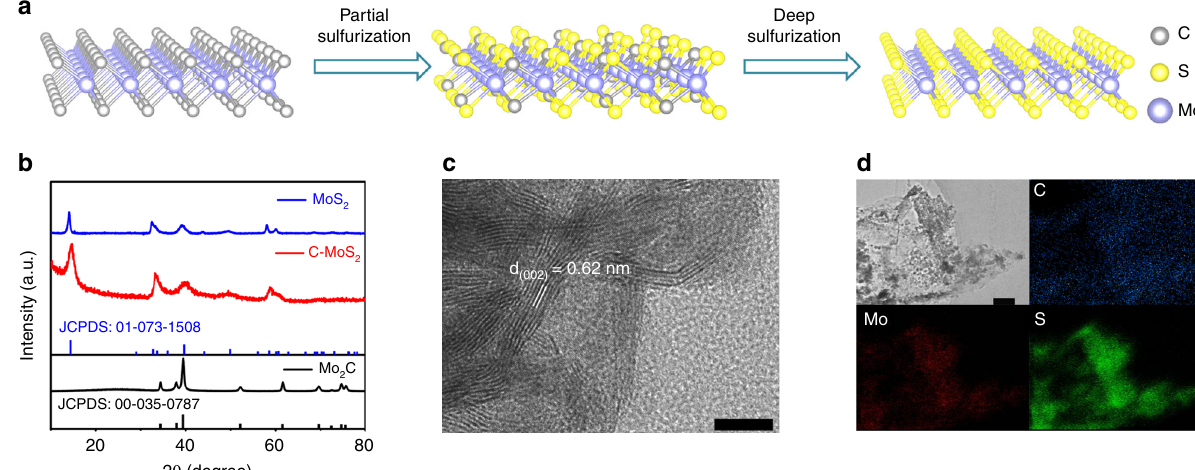
Fig. 2 Synthesis and characterization of C – MoS 2 nanosheets. a The schematic illustration of the synthesis of C – MoS 2 and MoS 2 . b The XRD patterns of Mo 2 C, C – MoS 2 , and MoS 2 . c The HRTEM image of C – MoS 2 . The scale bar is 10 nm. d The TEM image and the corresponding element mapping images of C, Mo, and S elements in C – MoS 2 . The scale bar is 200